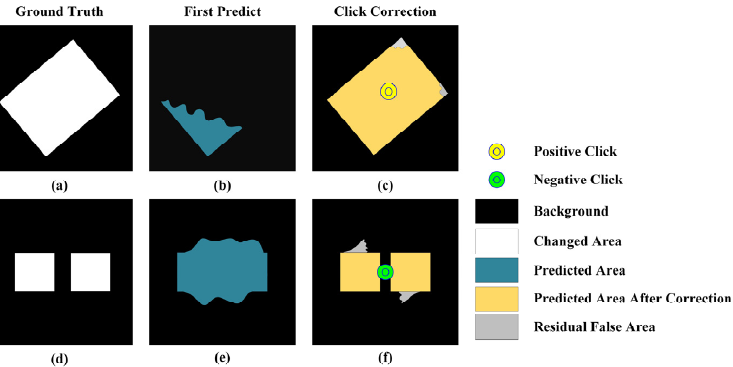
Figure 5. Schematic diagram of click correction range parameters. ( a ), ( d ) Ground Truth; ( b ), ( e ) First Predict Result; ( c ), ( f ) Click Correction Result.